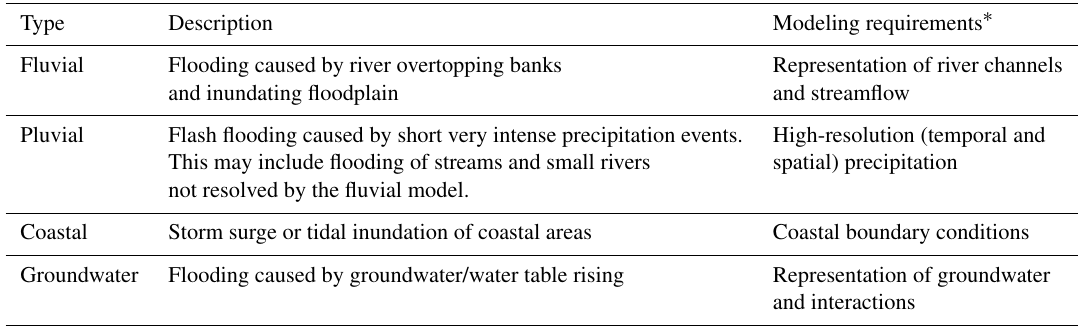
Table 5. Types of flood hazards and key modeling